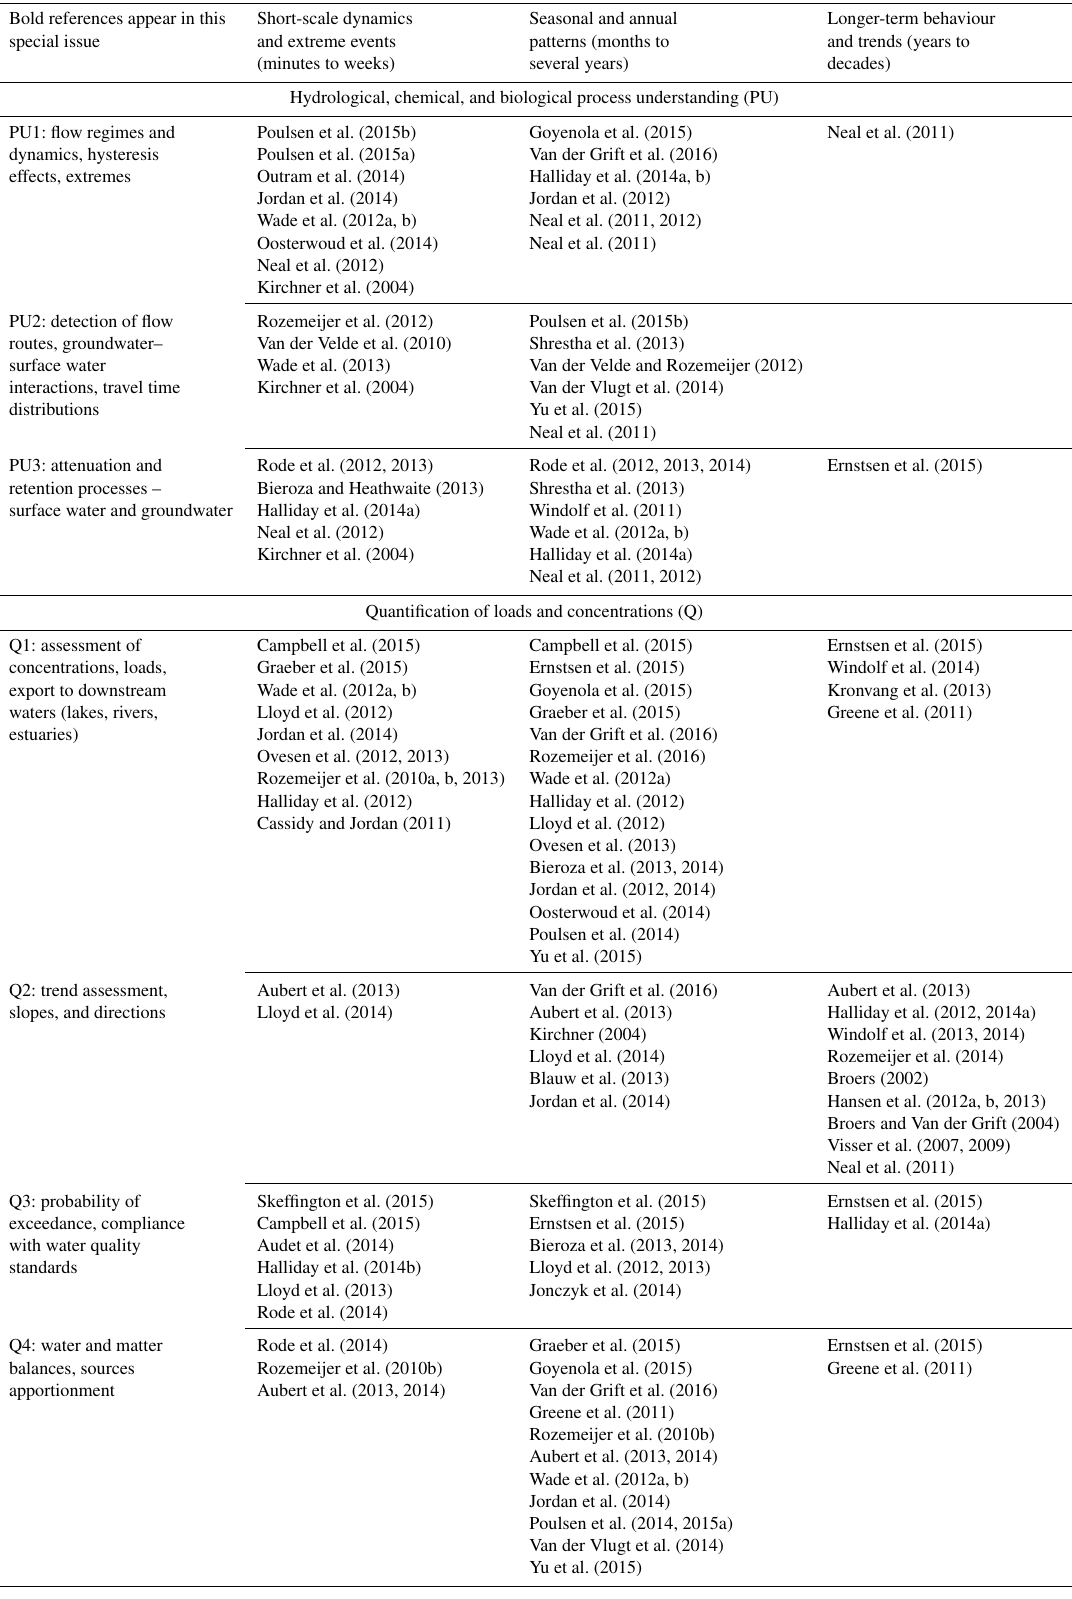
Table 1. Overview of monitoring objectives and timescales for high-frequency nutrient